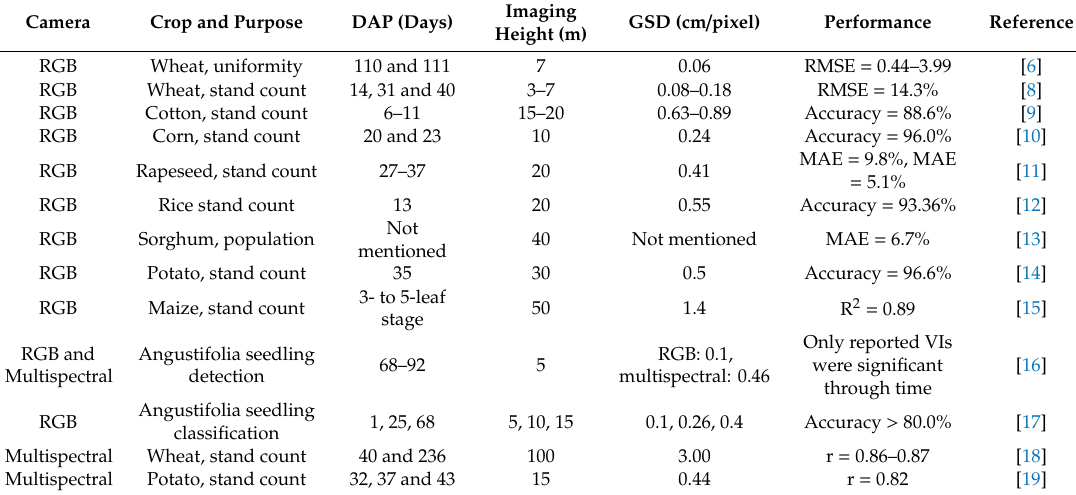
Table 1. A brief summary of studies for crop emergence assessment using unmanned aerial vehicle (UAV)-based